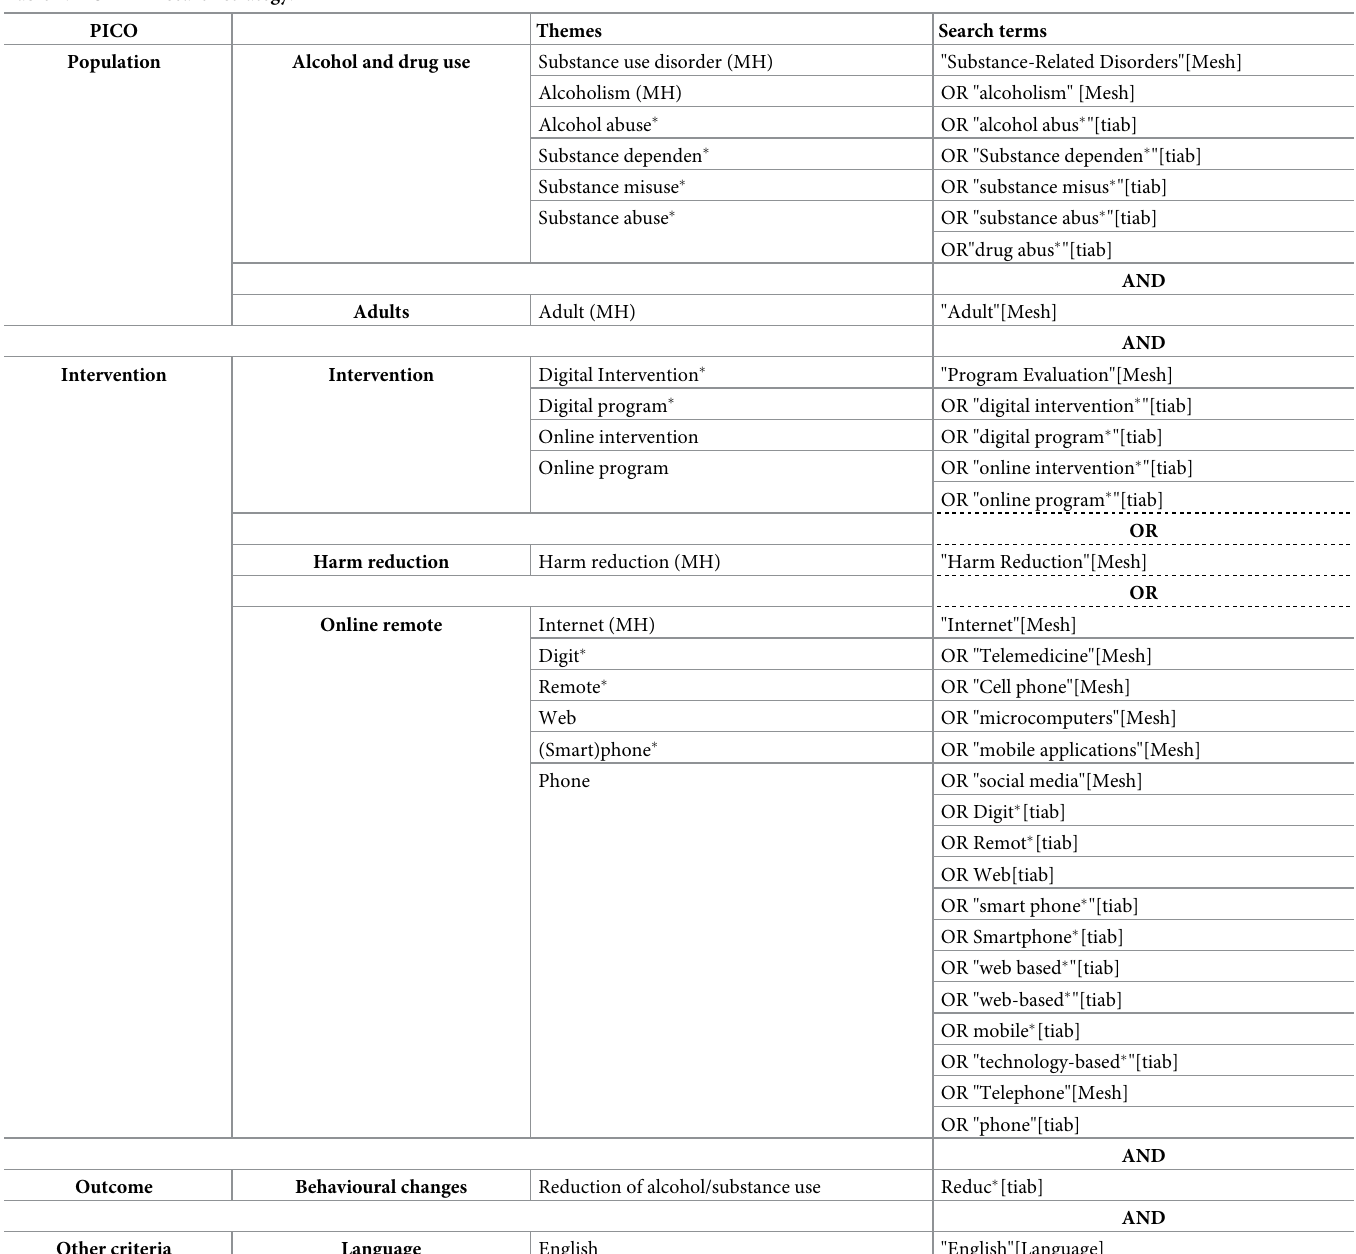
Table 1. PUBMED search